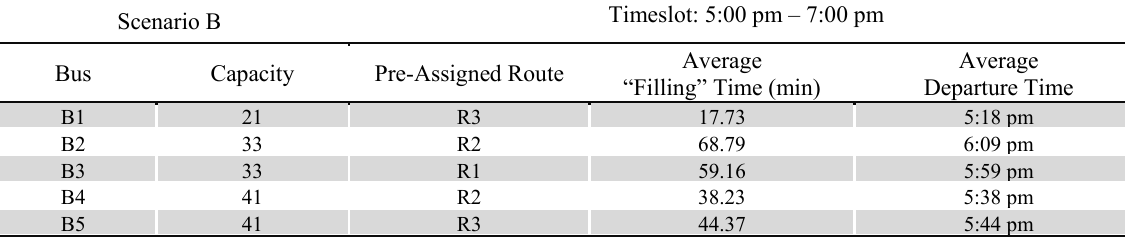
Results with the optimization-simulation